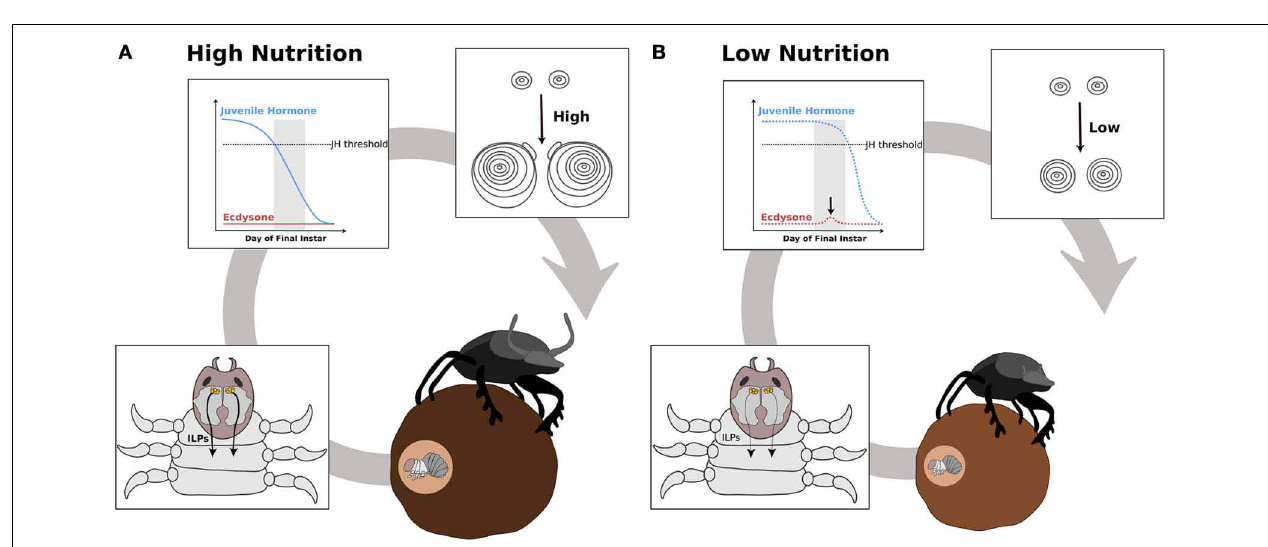
synthesis of ecdysone and juvenile hormone (JH), respectively. (A) In well-fed larvae, JH concentrations decline rapidly below a threshold (dashed gray line), as a consequence ecdysone does not rise during a critical stage near the end of the final larval instar (gray box). (B) In contrast, starved larvae have slower rates of JH decline, which triggers a small pulse of ecdysone at this stage. [Modified from Emlen and Allen (2003), Emlen et al. (2007)].